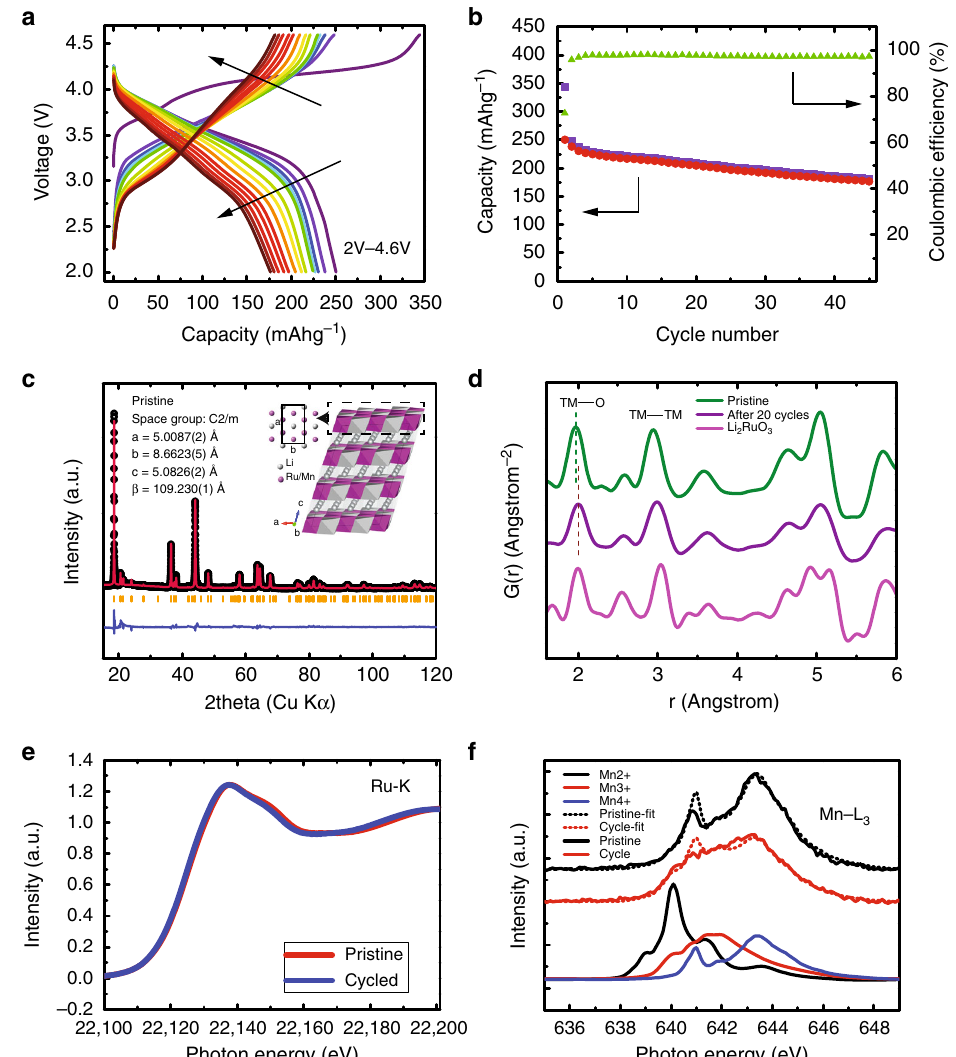
Fig. 1 Electrochemical, X-ray pair distribution function and absorption analysis of Li 2 Ru 0.5 Mn 0.5 O 3 (LRMO). a Charge/discharge curves of LRMO/lithium half-cell with cutoff voltages of 2 V and 4.7 V. b Charge/discharge capacity and coulombic ef fi ciency of LRMO half-cell as a function of charge cycle. c Synchrotron X-ray powder diffraction measurement of pristine LRMO (inset: atomic model of LRMO). d X-ray pair distribution function of pristine LRMO, LRMO after 20 cycles, and Li 2 RuO 3 as reference samples. e Hard X-ray absorption spectra of the pristine LRMO and LRMO after 15 cycles for the Ru K edge. f Soft X-ray absorption spectra of the pristine LRMO and LRMO after 15 cycles for the Mn L 3